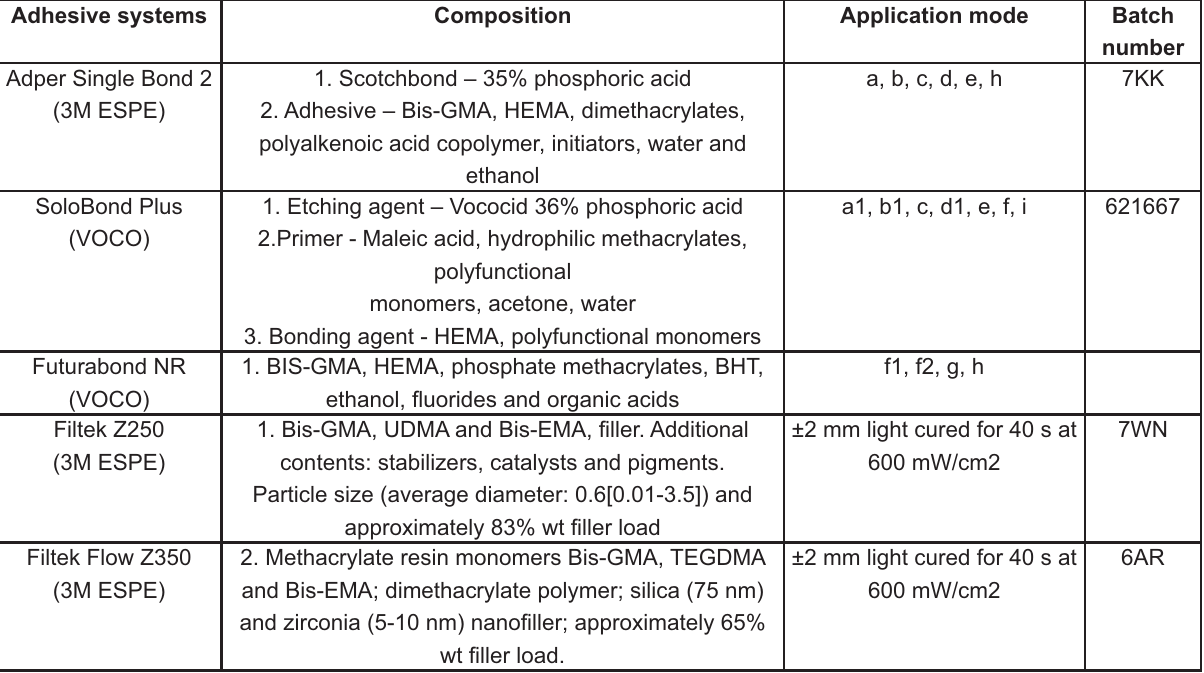
Figure 1- Composition, mode of application and batch number of the adhesives